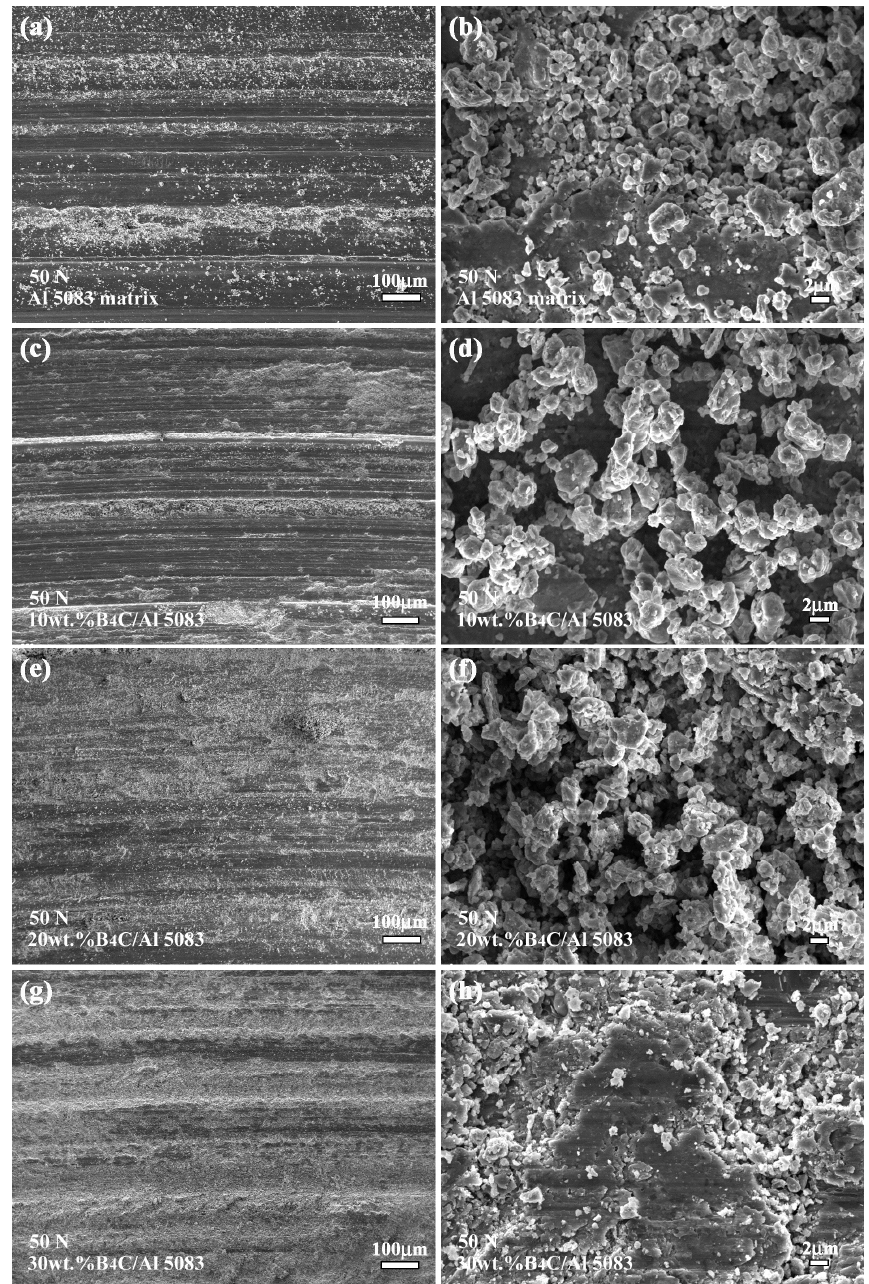
Figure 7. Worn surface of ( a ) Al 5083 matrix at 50 N; ( b ) magnified morphology of ( a ); ( c ) 10 wt % B 4 C/Al 5083 composite at 50 N; ( d ) magnified morphology of ( c ); ( e ) 20 wt % B 4 C/Al 5083 composite at 50 N; ( f ) magnified morphology of ( e ); ( g ) 30 wt % B 4 C/Al 5083 composite at 50 N and ( h ) magnified morphology of ( g ).